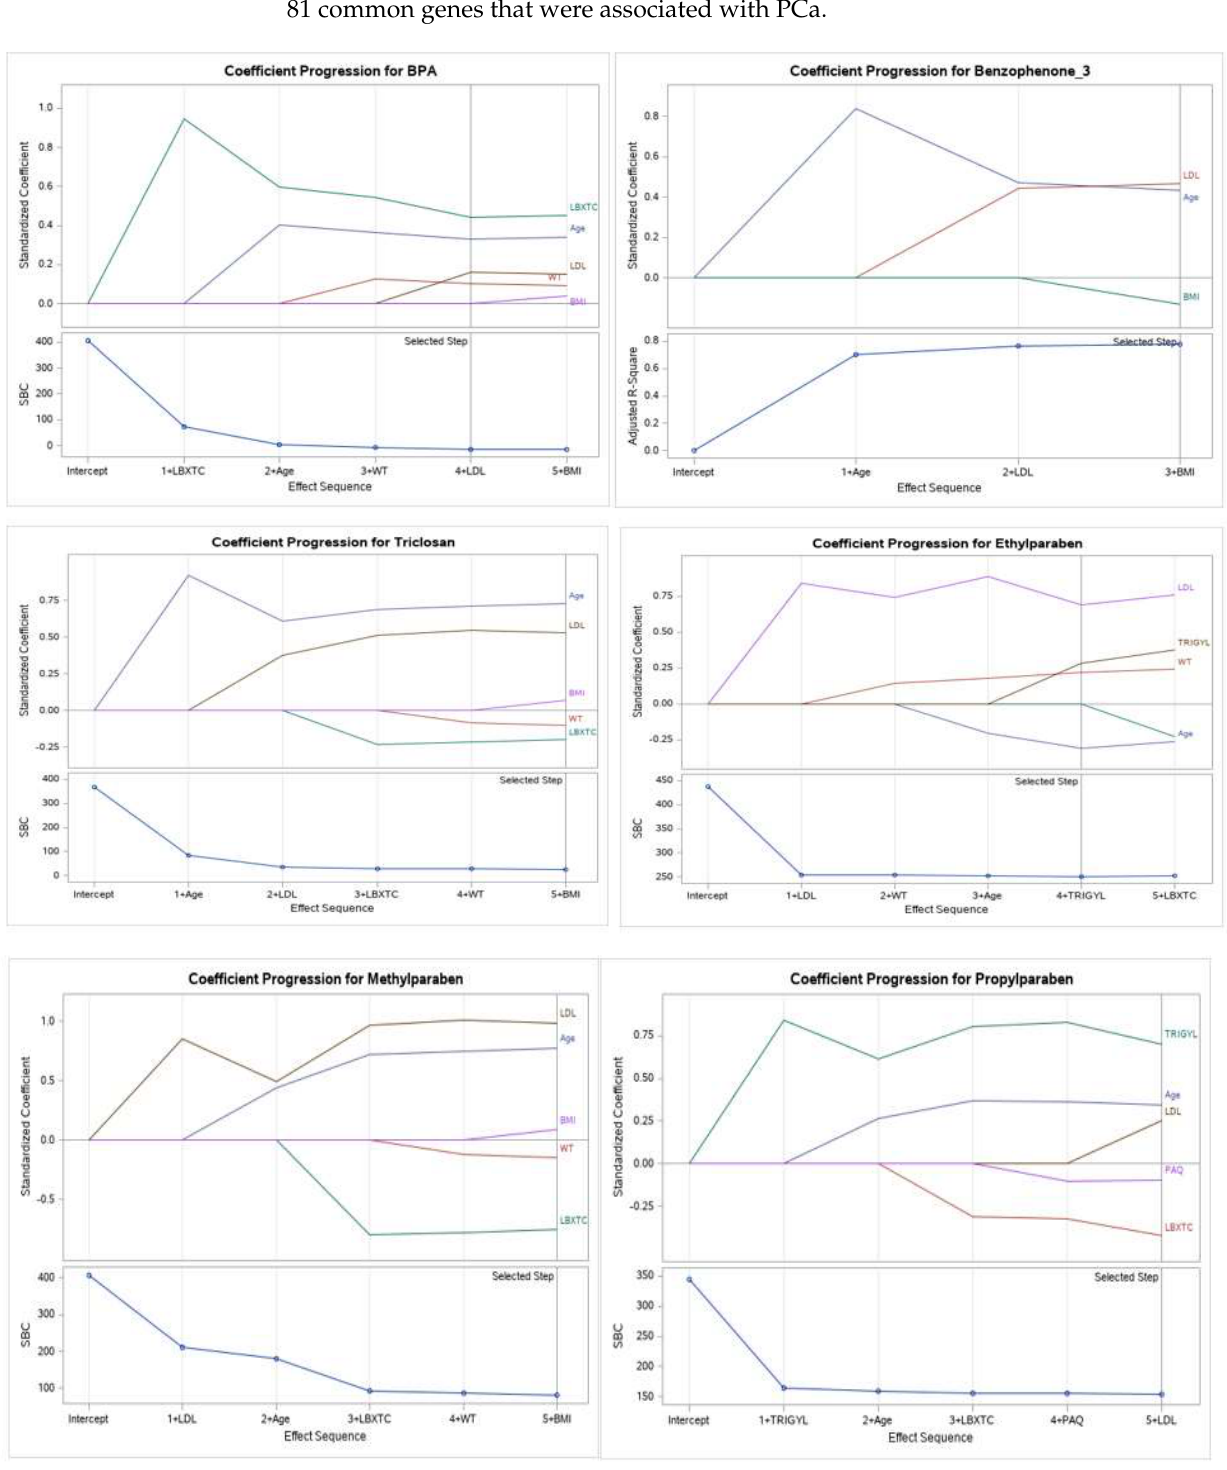
Figure 2. Coefficient progression with Schwartz’s Bayesian criterion ( SBC) for PCa cases for the six EPs and parabens metabolites (BPA, Benzophenone−3, Triclosan, Propylparaben, Ethylparaben, and Methylparaben) and PCa for men ≥20 years of age (NHANES 2005–2015), and quantitative and descriptive variables (total cholesterol LDL, triglycerides, age, BMI, weight, and physical activity).